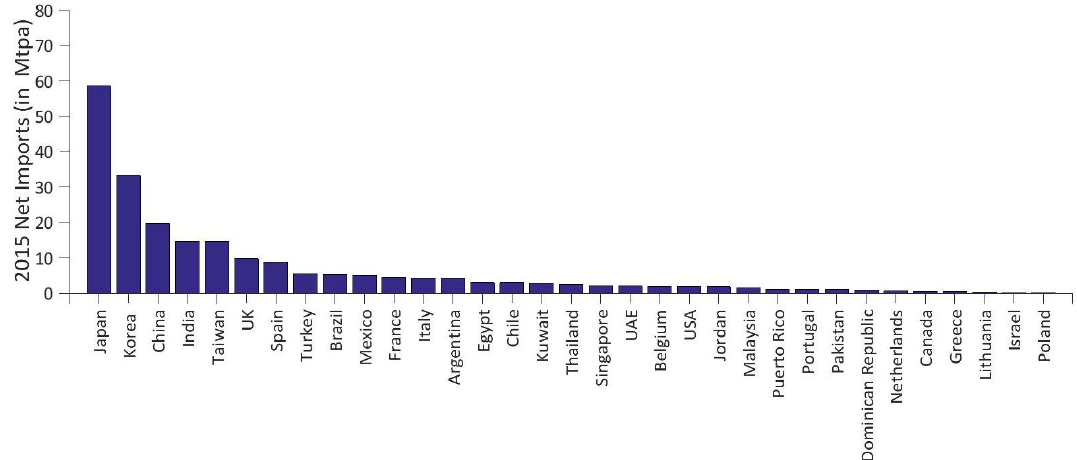
Figure 1. Global liquefied natural gas (LNG) importing countries and quantity 2015.